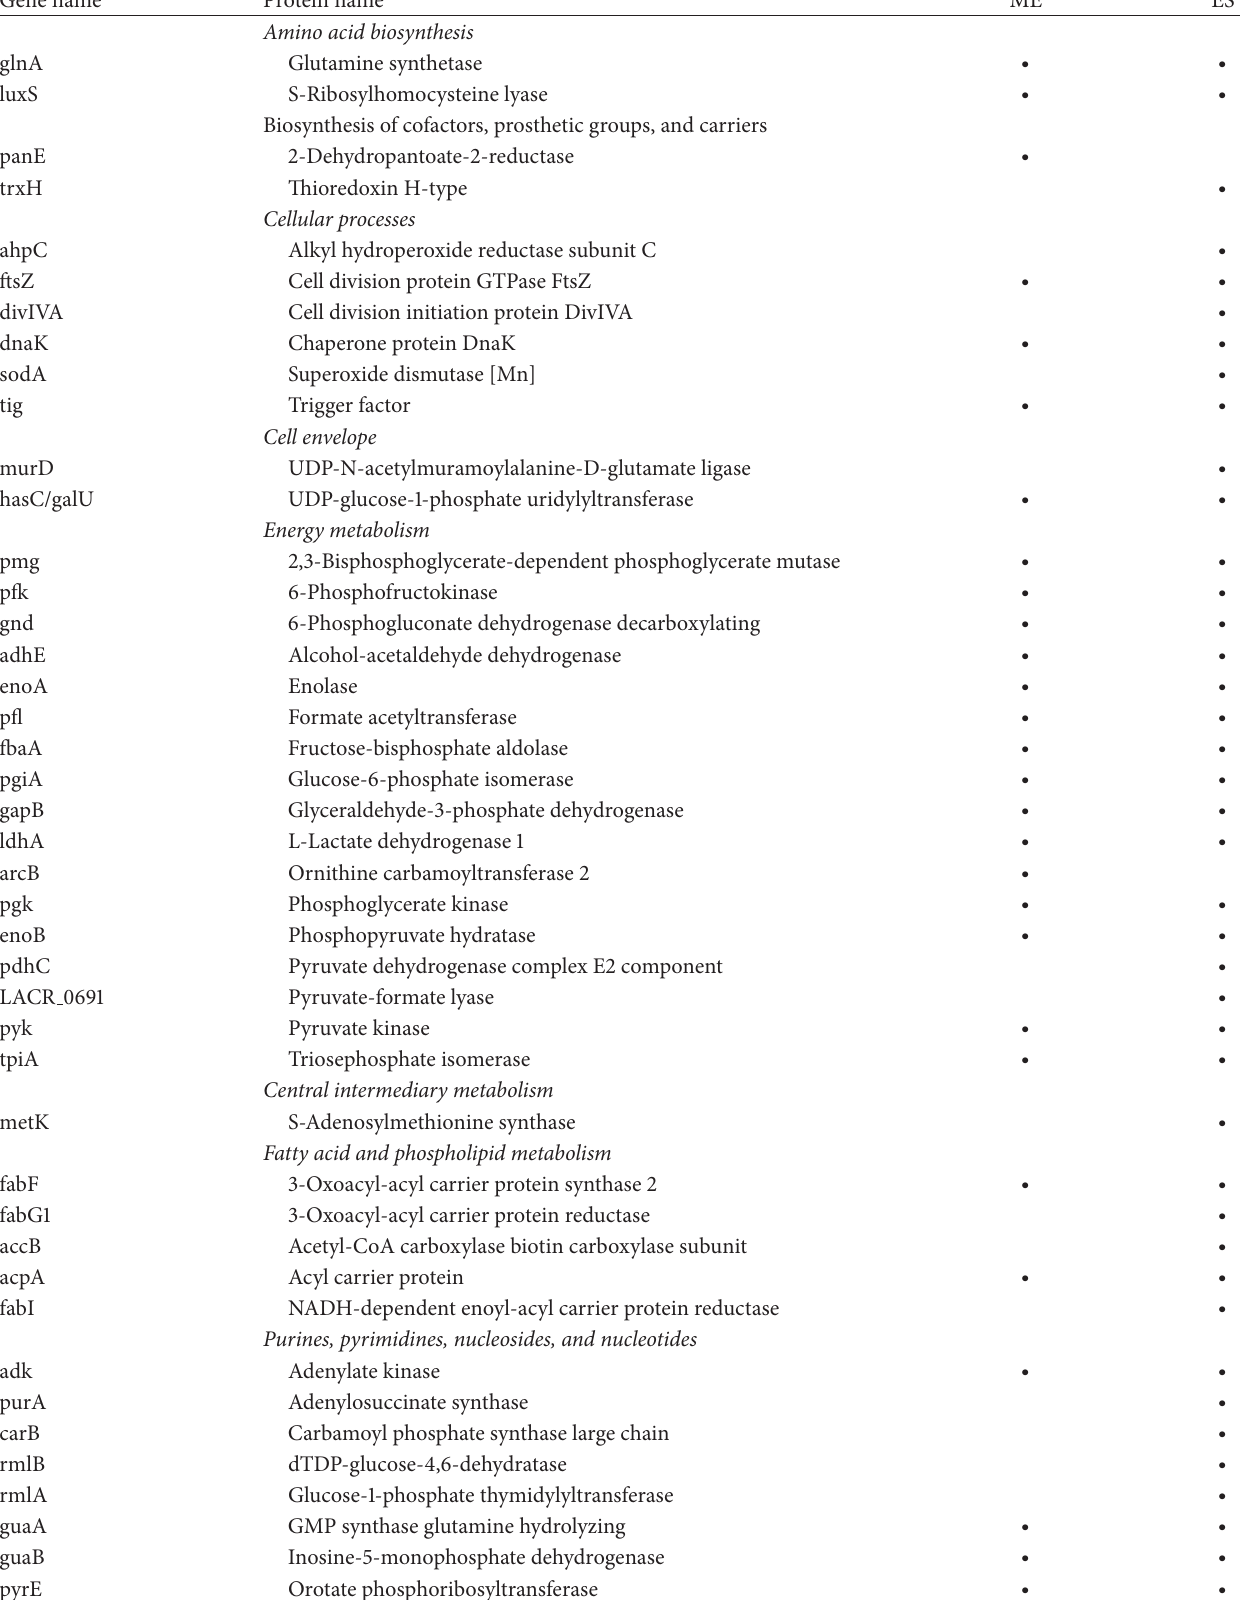
Table 1: List of the proteins identified at the midexponential (ME) and early stationary (ES) growth phases of L. lactis strain